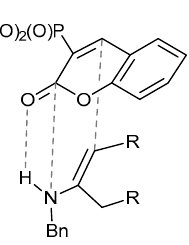
Figure 7. Proposed synclinal transition state formation.